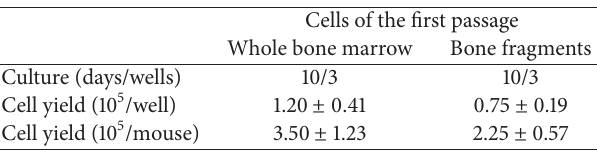
Table 1: Cell yields of the first passage from cultured bone marrow and bone fragments. Cells of the first passage Whole bone marrow Bone fragments